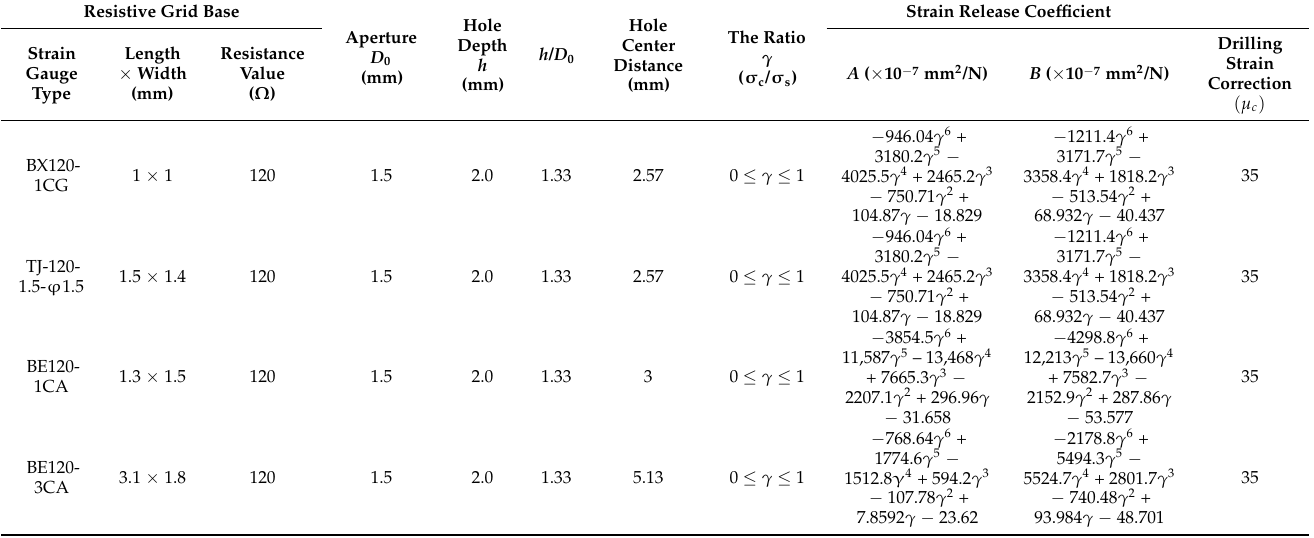
Table 2. Applicable conditions and specific values of strain release coefficients A and B